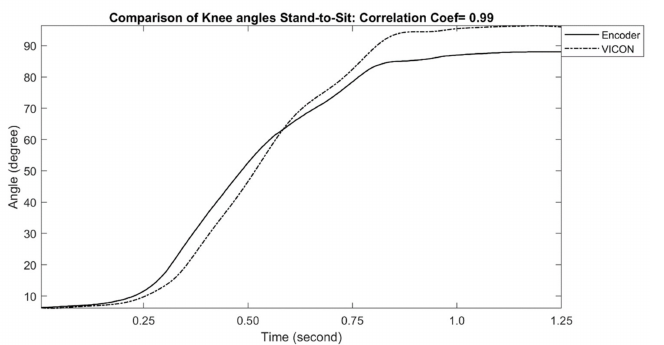
Figure 9. Comparison of Exo-skeleton’s knee angle measurement with reference motion capture during stand-to-sit. In this data, the correlation coefficient was calculated at 0.99.